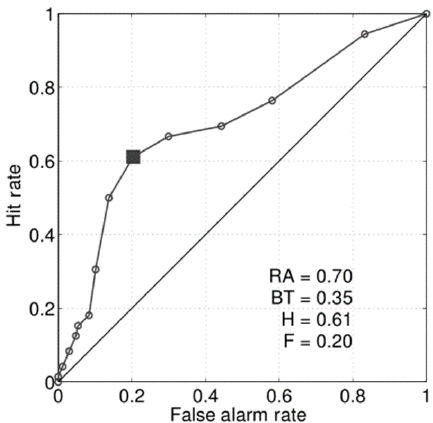
Figure 5. Relative operating characteristic (ROC) diagram for above-70th DPW predictions using the logistic regression of Eq. (1). The open dots indicate a set of probability forecasts by stepping a decision threshold with 5% probability through the mod- elling results. The numbers inside the plots are the ROC area (RA) and the best threshold (BT), here defined as the threshold that max- imises the difference between the hit rate ( H ) and the false alarm rate ( F